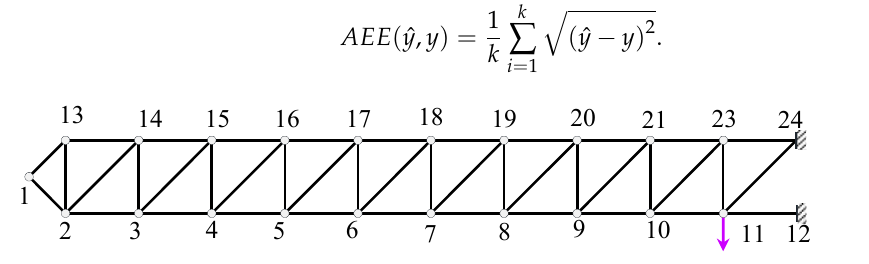
Figure 2. Planar truss structure. Adapted from